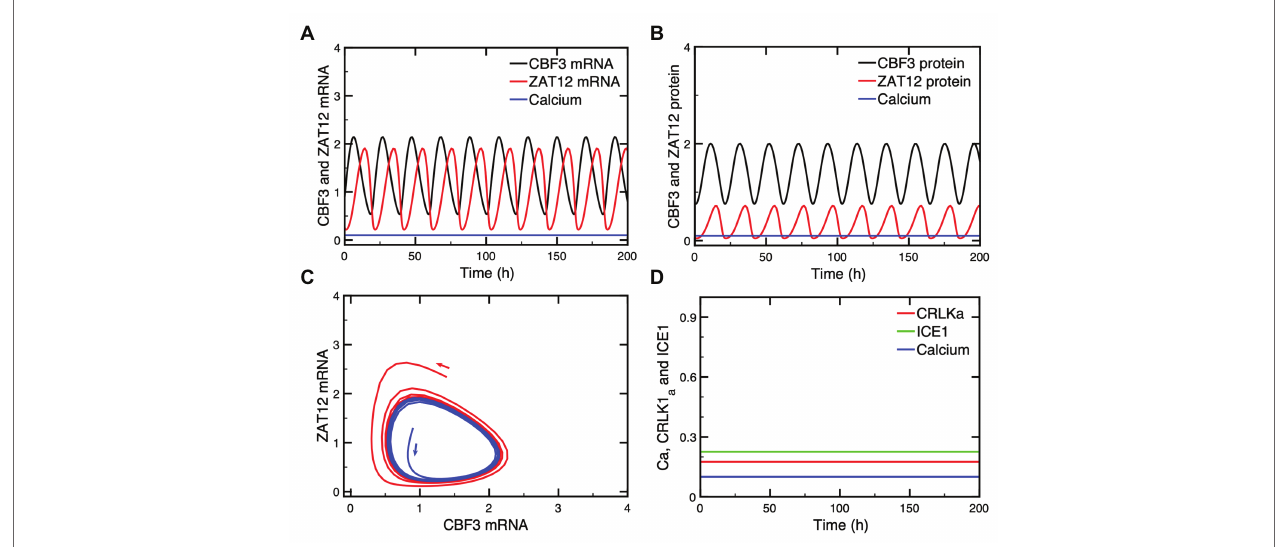
FIGURE 7 | Oscillations in CBF3 expression in the absence of a cold shock. In some conditions, oscillations can occur spontaneously in some state variables of the cold response pathway, such as CBF3 and ZAT12, both in their mRNAs (A) and protein levels (B) . When the levels of CBF3 and ZAT12 mRNAs are plotted against each other in the course of time, the oscillations correspond to the evolution toward a closed curve known as a limit cycle (C) . This limit cycle can be reached starting from different initial conditions, as shown by the trajectories in blue and red in (C) . By contrast, other state variables located upstream of CBF3 in the cold response pathway do not oscillate, as shown in (D) for CRLK1a (red curve) and ICE1 (green curve) which remain at a stable steady state, in the absence of cold stress. The Ca 2+ level (blue curve) accordingly remains also at a stable steady state level. The curves are obtained by numerical integration of eqs. (1), (3), and (4)–(17) from Supplementary Material Sections 1 and 2. Parameter values are listed in Supplementary Table 2 except for the following parameters: K a2 = 0.55, K I2 = 0.8, K I3 = 0.2, K d3 = 1.8, k s1 = 0.25, v d5 = 3.8, v s3 = 3.5, K a3 = 0.8, v d6 = 3.2, k s2 = 0.55, v d7 = 3.65, and k d7 = 0.1 (see Supplementary Table 2 for the definitions and units of these